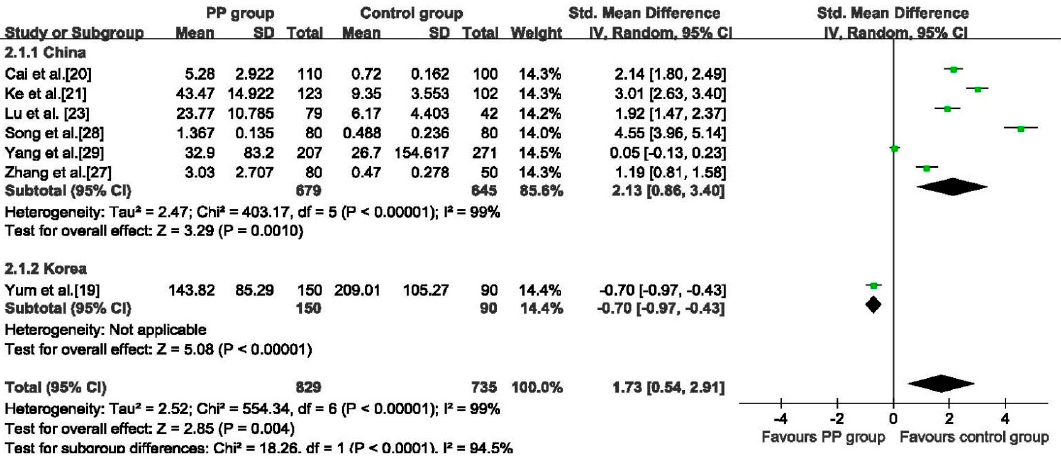
Figure 4. Forest plot for serum concentration of DEHP between PP group and control group.